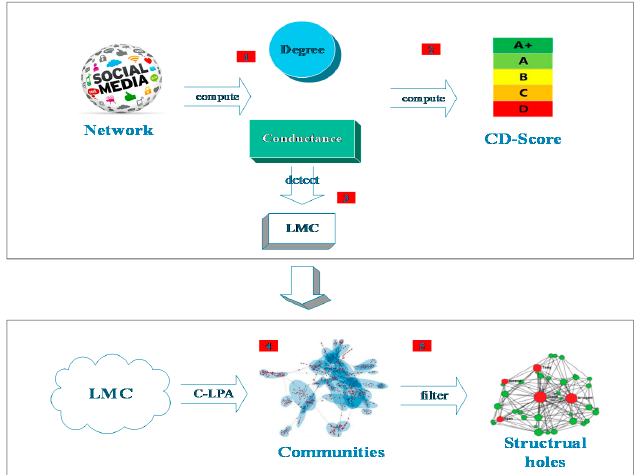
Figure 3. Illustration of the Conductance–Degree structural hole detection algorithm (CD-SHA). CD-SHA includes 5 steps: (1) Compute the conductance and degree; (2) Calculate CD-score; (3) Identify the local minimum community (LMC) structure in the network; (4) Detect communities by the label propagation algorithm based on conductance (C-LPA); (5) Identify the structural hole spanners according to their CD-scores after filtering.